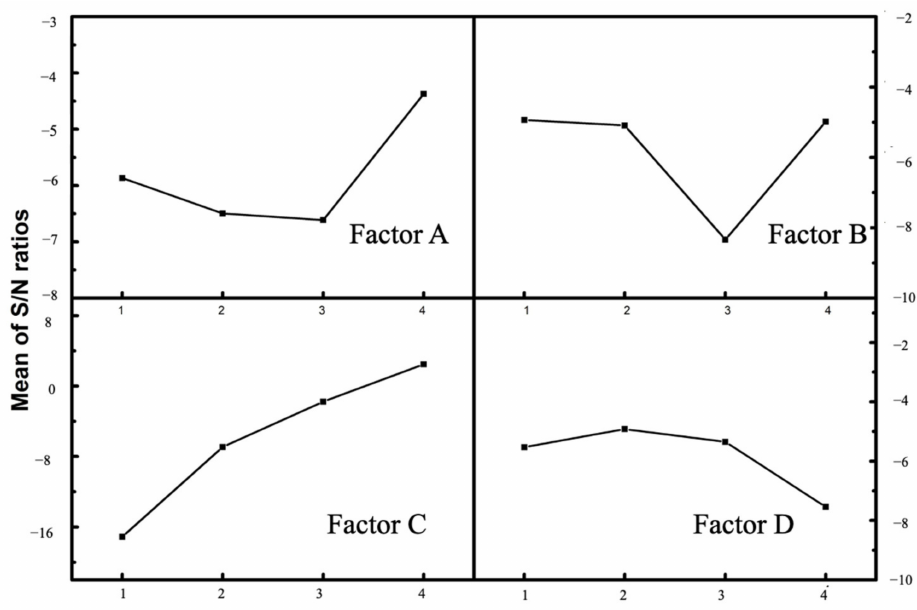
Figure 2. S / N ratio plots for the effects of experimental parameters for ascorbic acid.